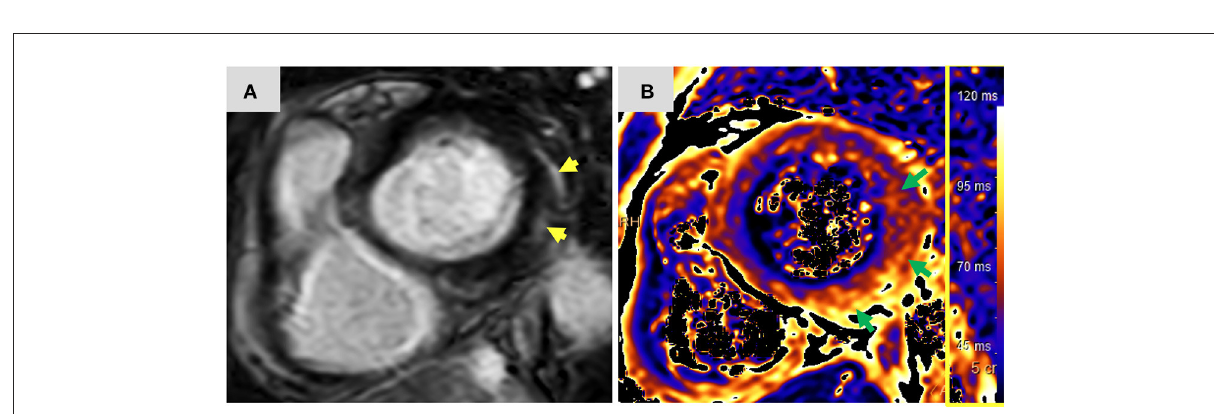
FIGURE2 Magnetic resonance imaging findings: Short axis view (A) of late gadolinium enhancement illustrates sub-epicardial and mid-wall late gadolinium enhancement in the basal infero-lateral and antero-lateral segments (yellow arrows). The corresponding short axis view of T2 mapping (B) illustrates extensive diffuse interstitial myocardial edema (green arrows). Diffuse T2 value was 56.2ms and focal T2 value in the infero-lateral segment was 61ms (normal limit 55ms). The presence of myocardial injury and extensive edema support the diagnosis of